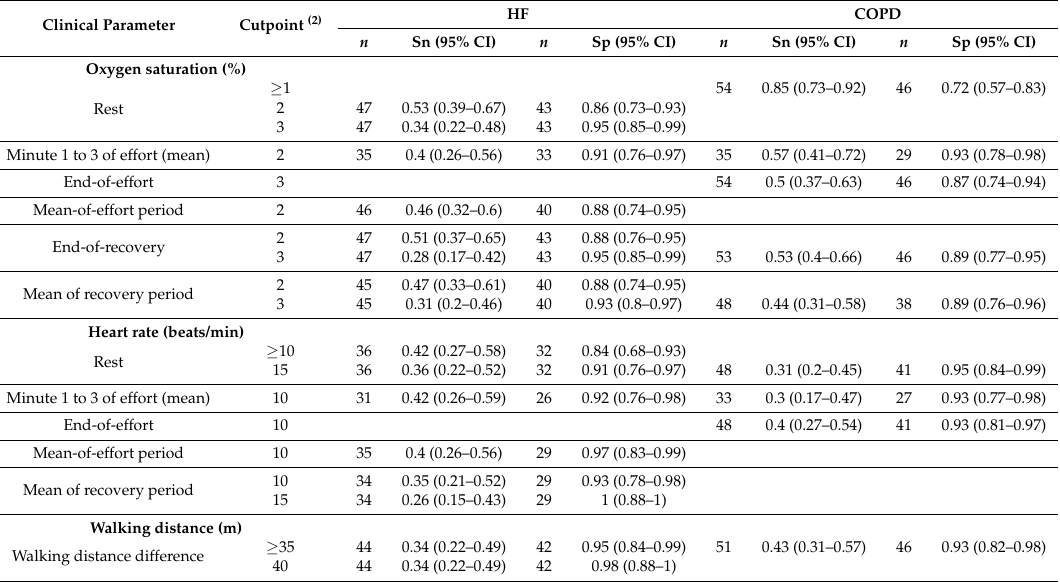
Figure 3. HR and SaO2 during evaluation sessions. ( a , b ): SaO 2 and HR of HF patients, respectively; ( c , d ): SaO 2 and HR of COPD patients, respectively. Table 3. Parameters with relevant discriminatory power (1) for detection of clinical Table 2. Physiological parameters according to disease and exacerbation/stable phase.